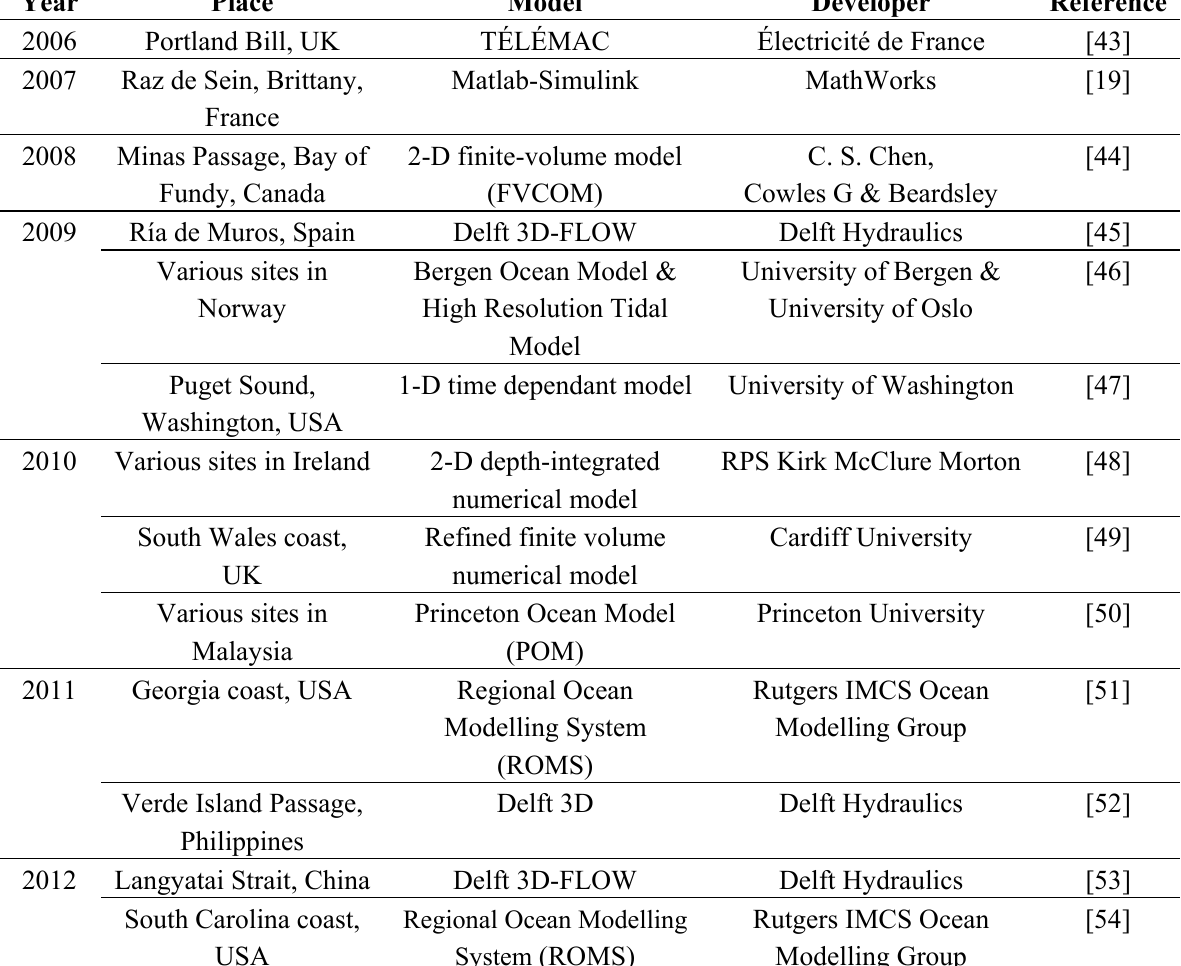
Table 1. Numerical assessment of marine current energy by various